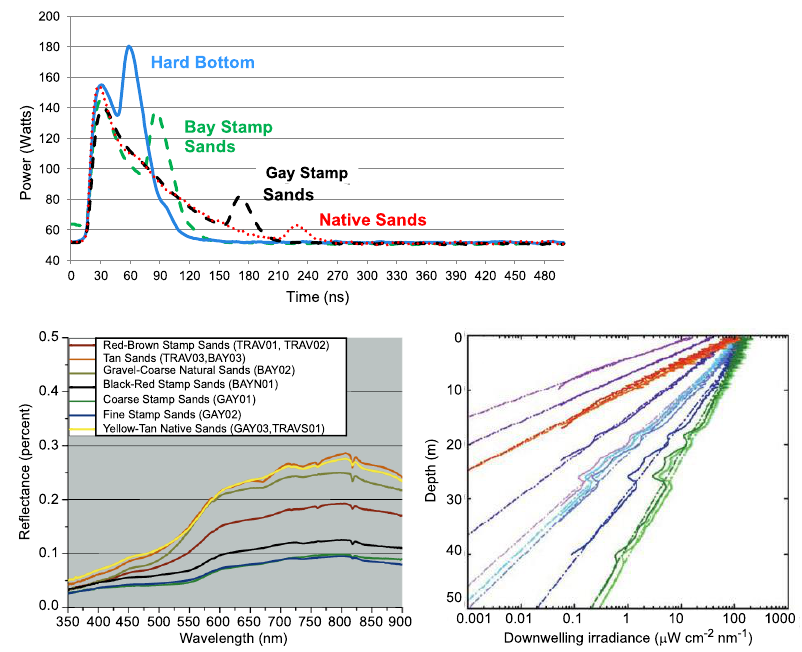
Figure 3. Optical measurements from Grand Traverse Bay: Examples of LiDAR wave-forms from different bottom substrates (top; bottom substrates = “Hard-bottom” = Jacobsville Sandstone; “Gay Stamp Sands” = e.g., GAY01, GAY02; “Native Sands” = e.g., TRA03, BAY03, GAY03, TRAVS01); In-situ spectral reflectance (bottom left) of slightly submersed (1–2 cm) sediment types near Gay (note low reflectance of coarse and fine basaltic stamp sands vs high reflectance of natural quartz sands); Example data from Satlantic OC P1000 Optical Profiling Radiometer (bottom right), where each color represents a different spectral band. Dashed straight lines represent spectral regression lines using the Beer-Lambert’s law equation. In these Class 2 coastal waters, notice how blues and greens (right lines) penetrate much deeper than red wavelengths.